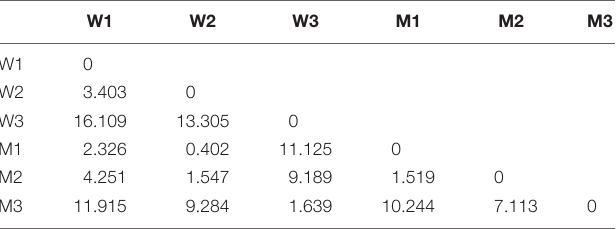
TABLE 7B | Moderation analysis: critical ratio for differences (comparison between men and women for PsyCap).